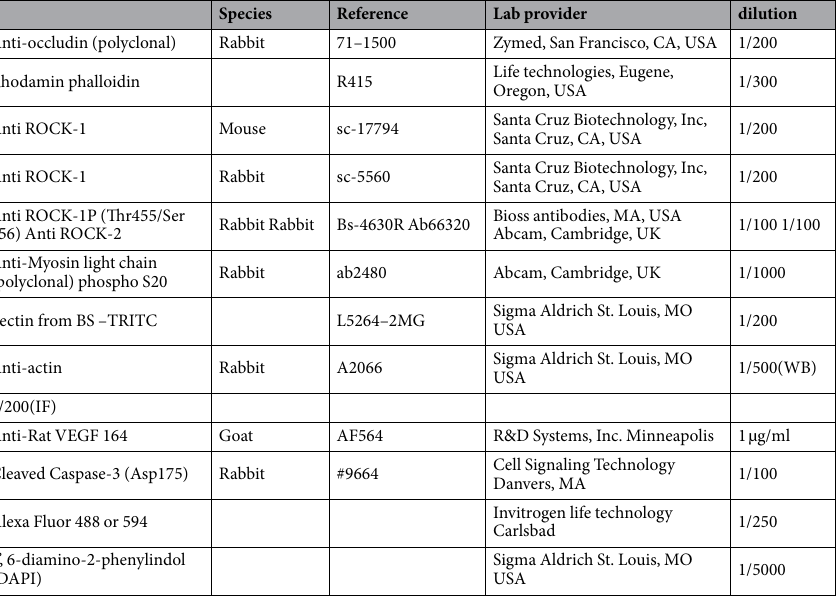
Table 2. List and details of antibodies. BS, Bandeiraea